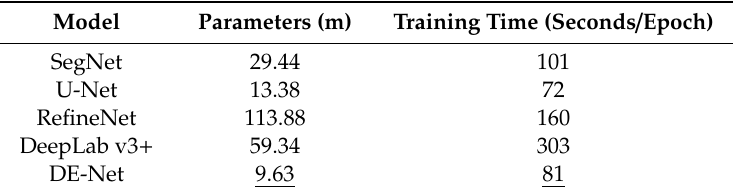
Table 4. Complexity comparison of SegNet, U-Net, RefineNet, DeepLab v3 + , and DE-Net (the lowest value is